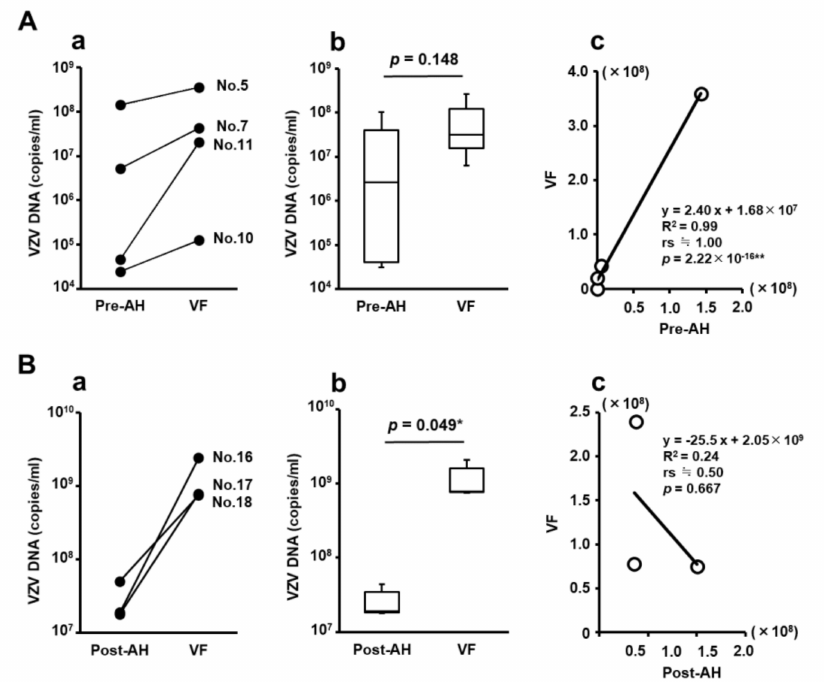
Figure 3. Comparison and correlation of viral loads in ocular fluids of the same patients before and after intravenous acyclovir treatment. ( A ) Paired samples of Pre-AH and VF in ARN patients with VZV infection. ( B ) Paired samples of Post-AH and VF in ARN patients with VZV infection. R 2 : coefficient of determination, rs: Spearman's rank correlation coefficient, ≒ approximately equal, *: p <